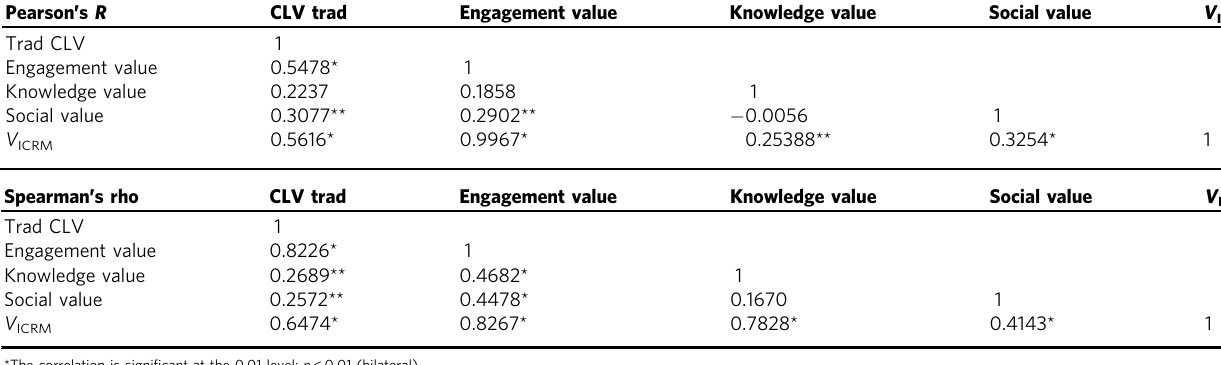
Table 8 Correlation matrix of the components of V ICRM , including comparison with traditional CLV. Pearson ’ s